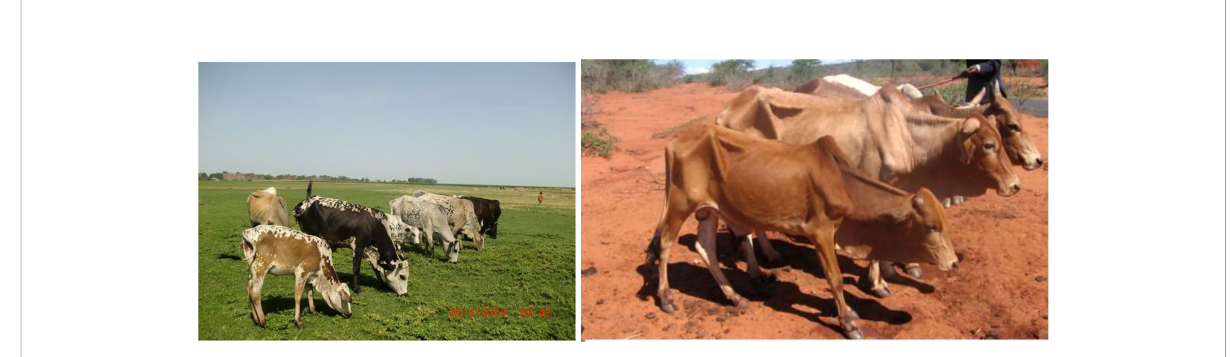
FIGURE 4 Diluted (mixed) Fogera cattle (left) and highland zebu breed (right).